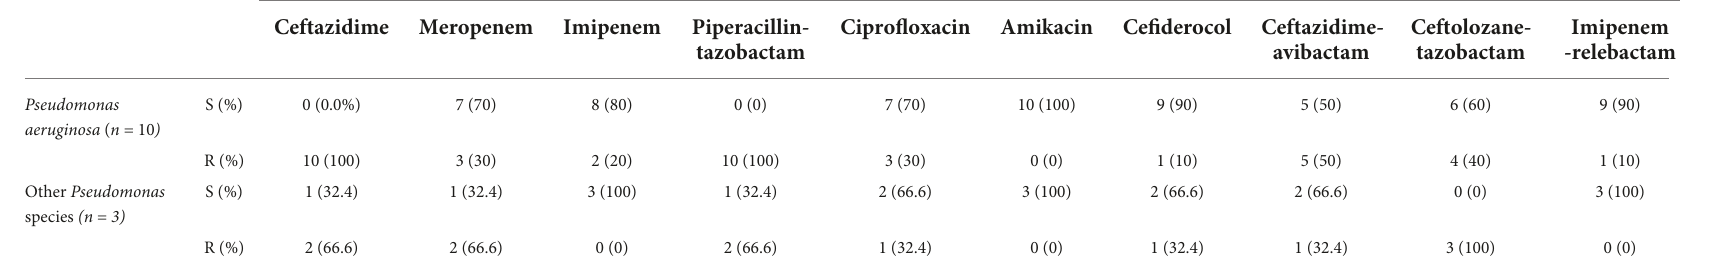
TABLE 2A Antimicrobial susceptibility pattern of ceftazidime resistant Pseudomonas spp. isolated at JMC, Ethiopia. Bacterial species